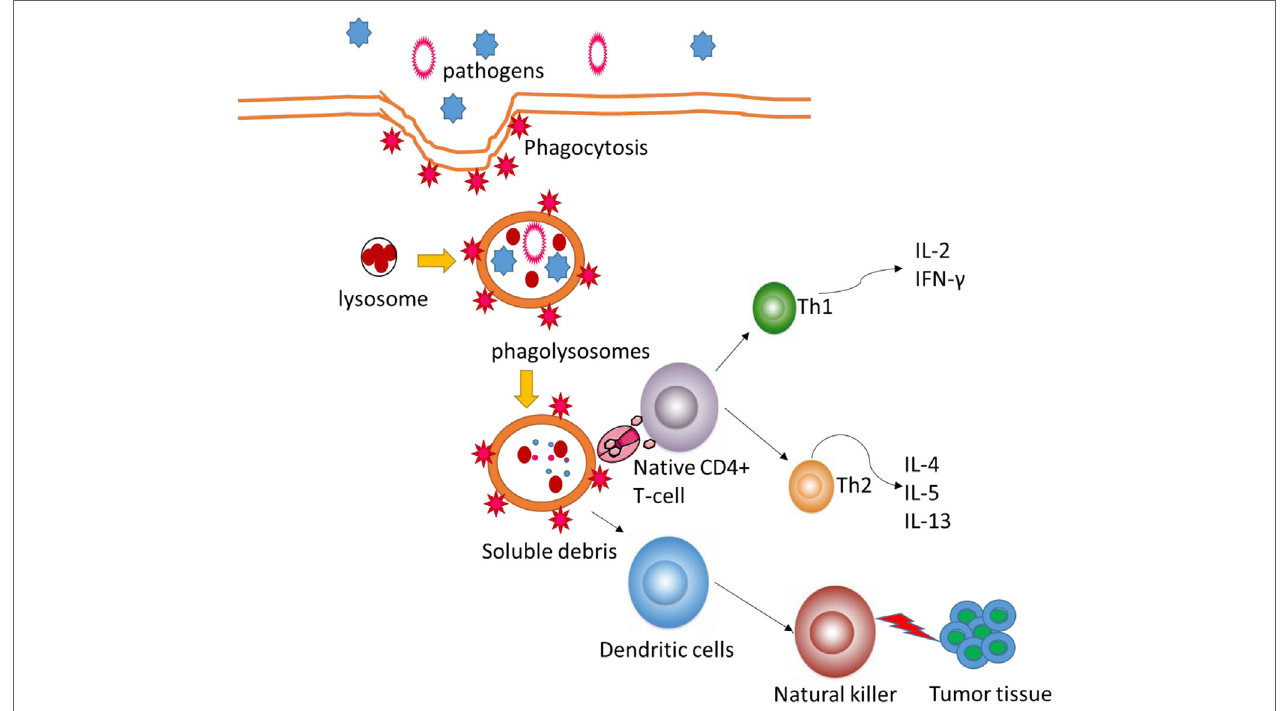
FiguRe 2 | Pectin oligosaccharides regulate cellular autophagous activities by affecting natural killer.